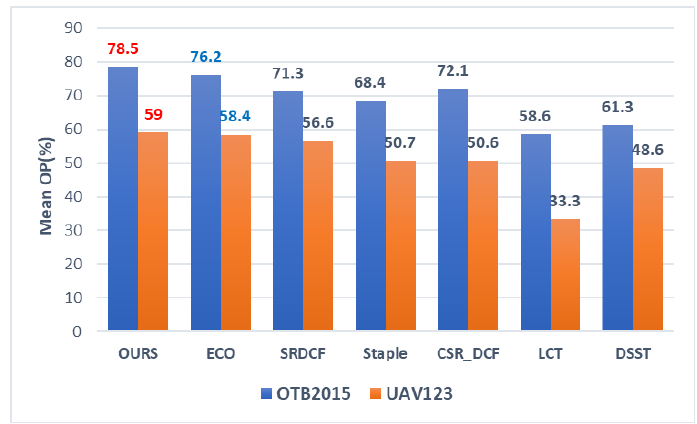
Figure 4. Comparison of Mean overlap precision score (OP) on OTB 2015 and UAV123 datasets.